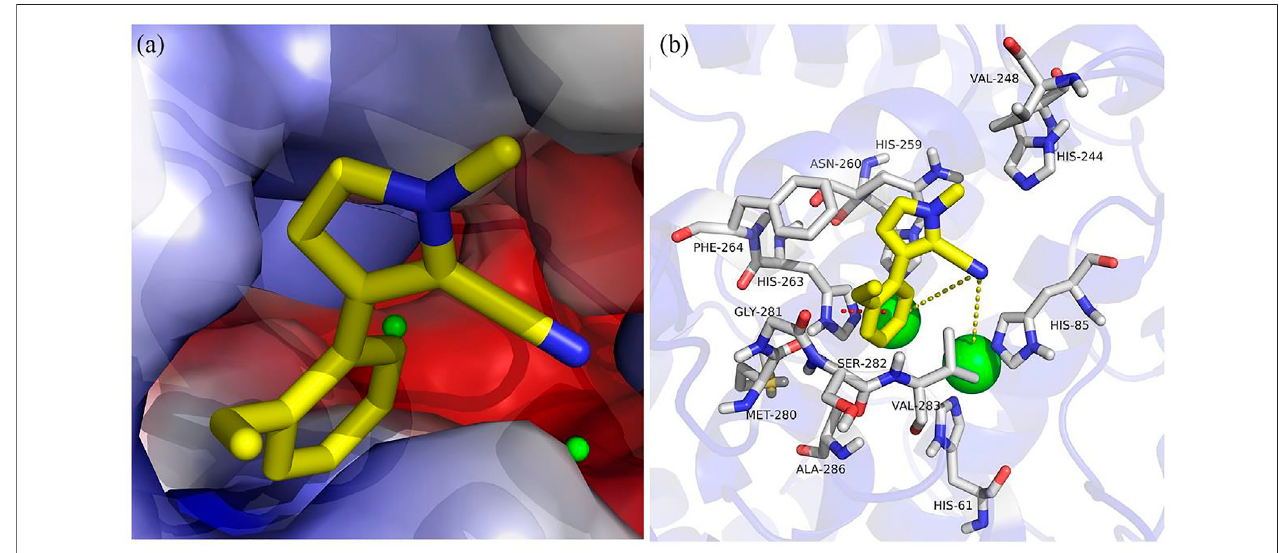
FIGURE 3 | Molecular docking of compound A12 with tyrosinase: (A) in the active pocket; (B) interactions with amino acid residues.